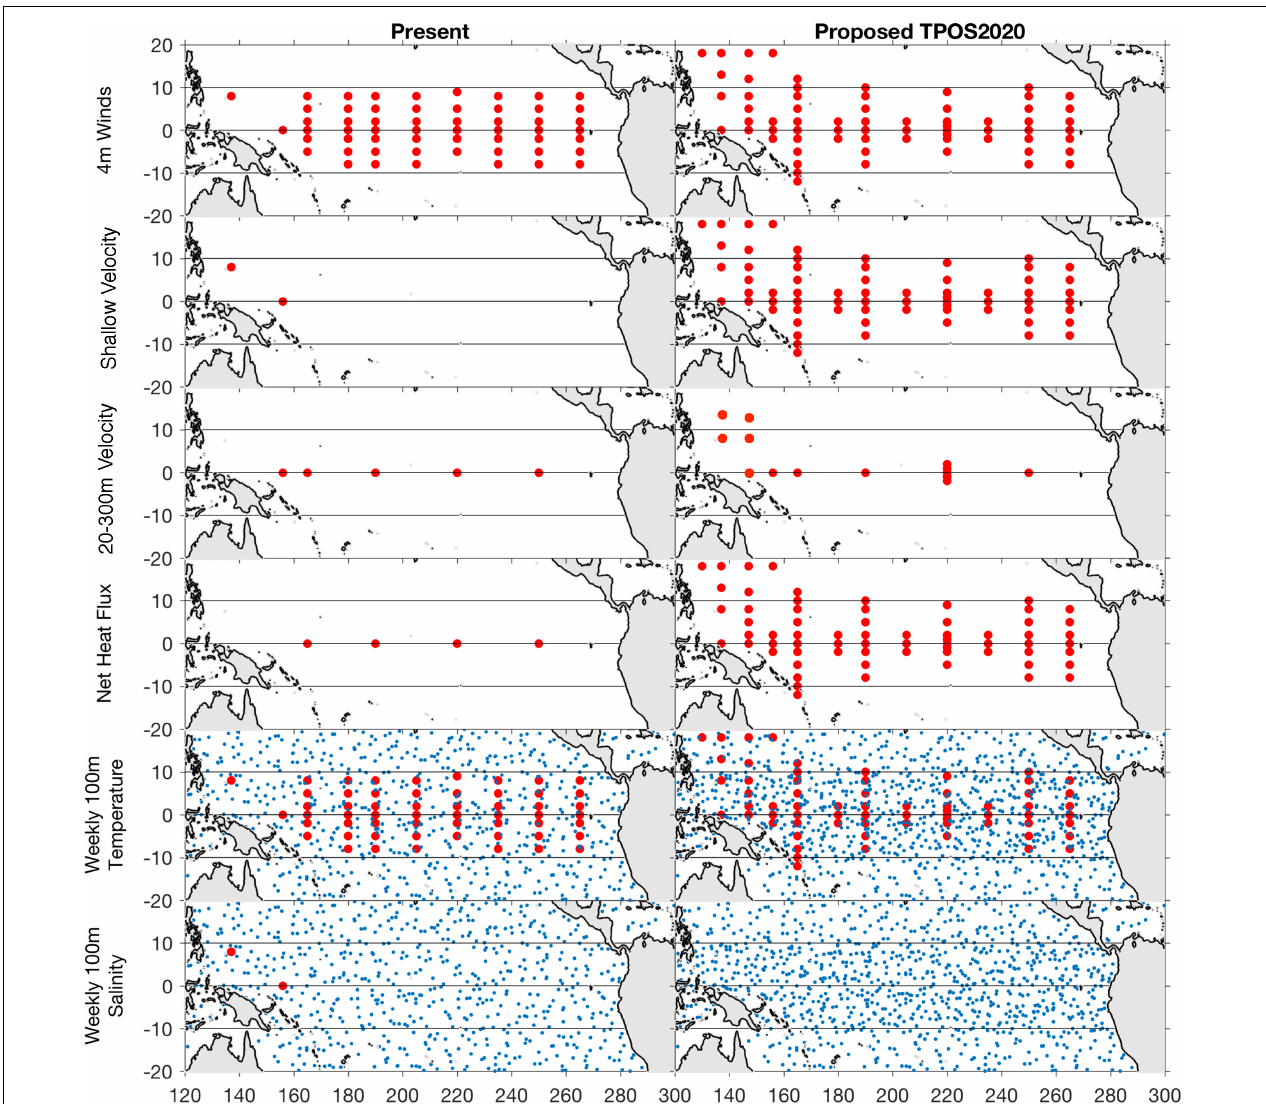
FIGURE 2 | Schematic showing data returns from the TMA and Argo for key variables of interest between the present observing system (left) and the proposed TPOS 2020 Backbone (right) . Observations from the TMA are shown in large circles and Argo in smaller dots. Improvements in surface flux, velocity and subsurface sampling are expected. Further extensions of the TMA are under